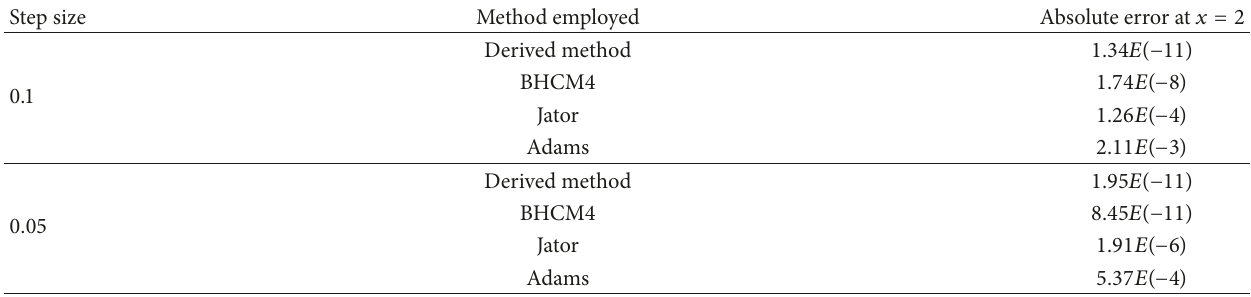
Table 2: Comparison of the derived method with [15, 16] and Adams Bashforth-Adams Moulton method.